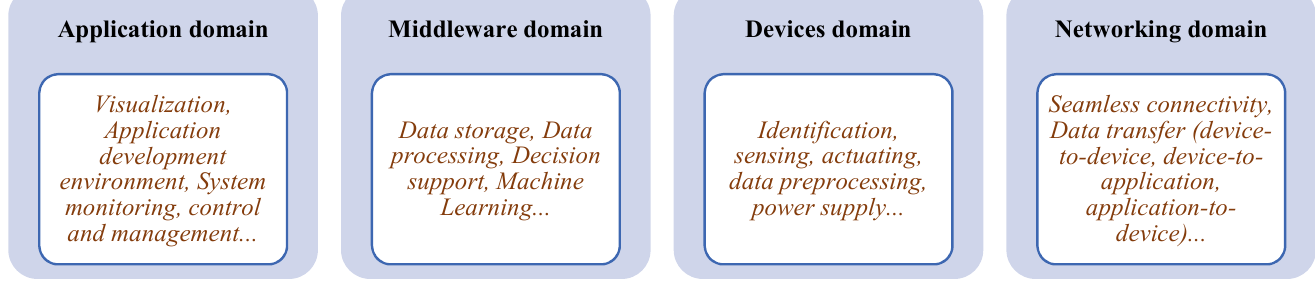
Figure 1. IoT functional domains